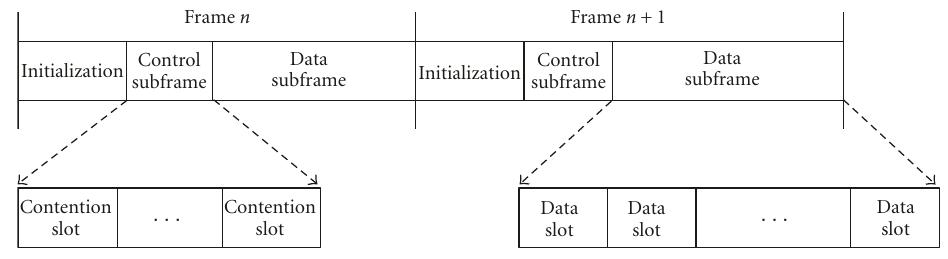
Figure 3: Frame structure of the distributed SAM protocol, which resembles that of MSH-DSCH in IEEE